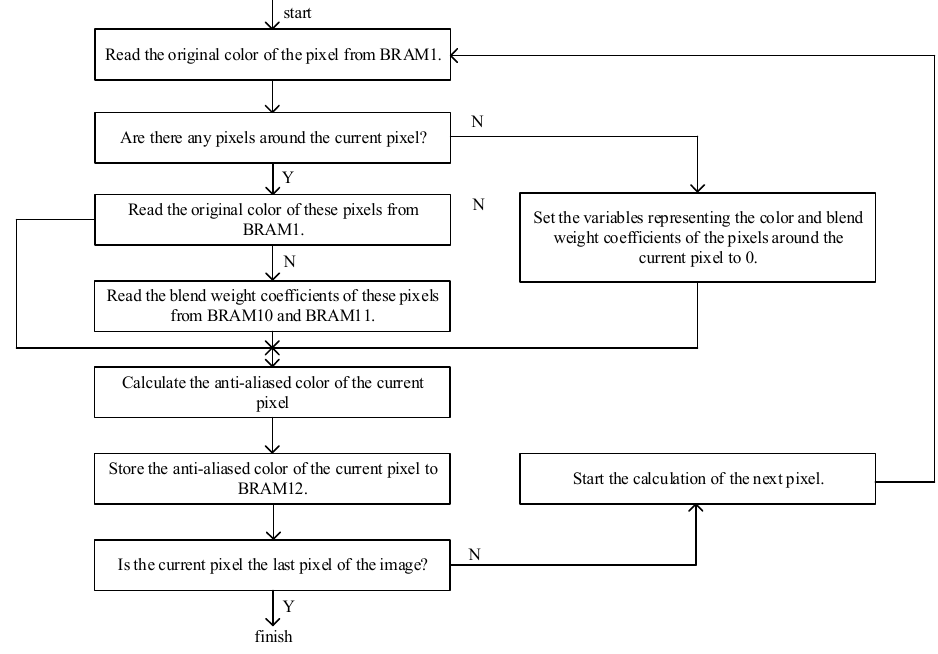
Figure 12. Flow diagram of the module Calculate_Aliasing_Color.